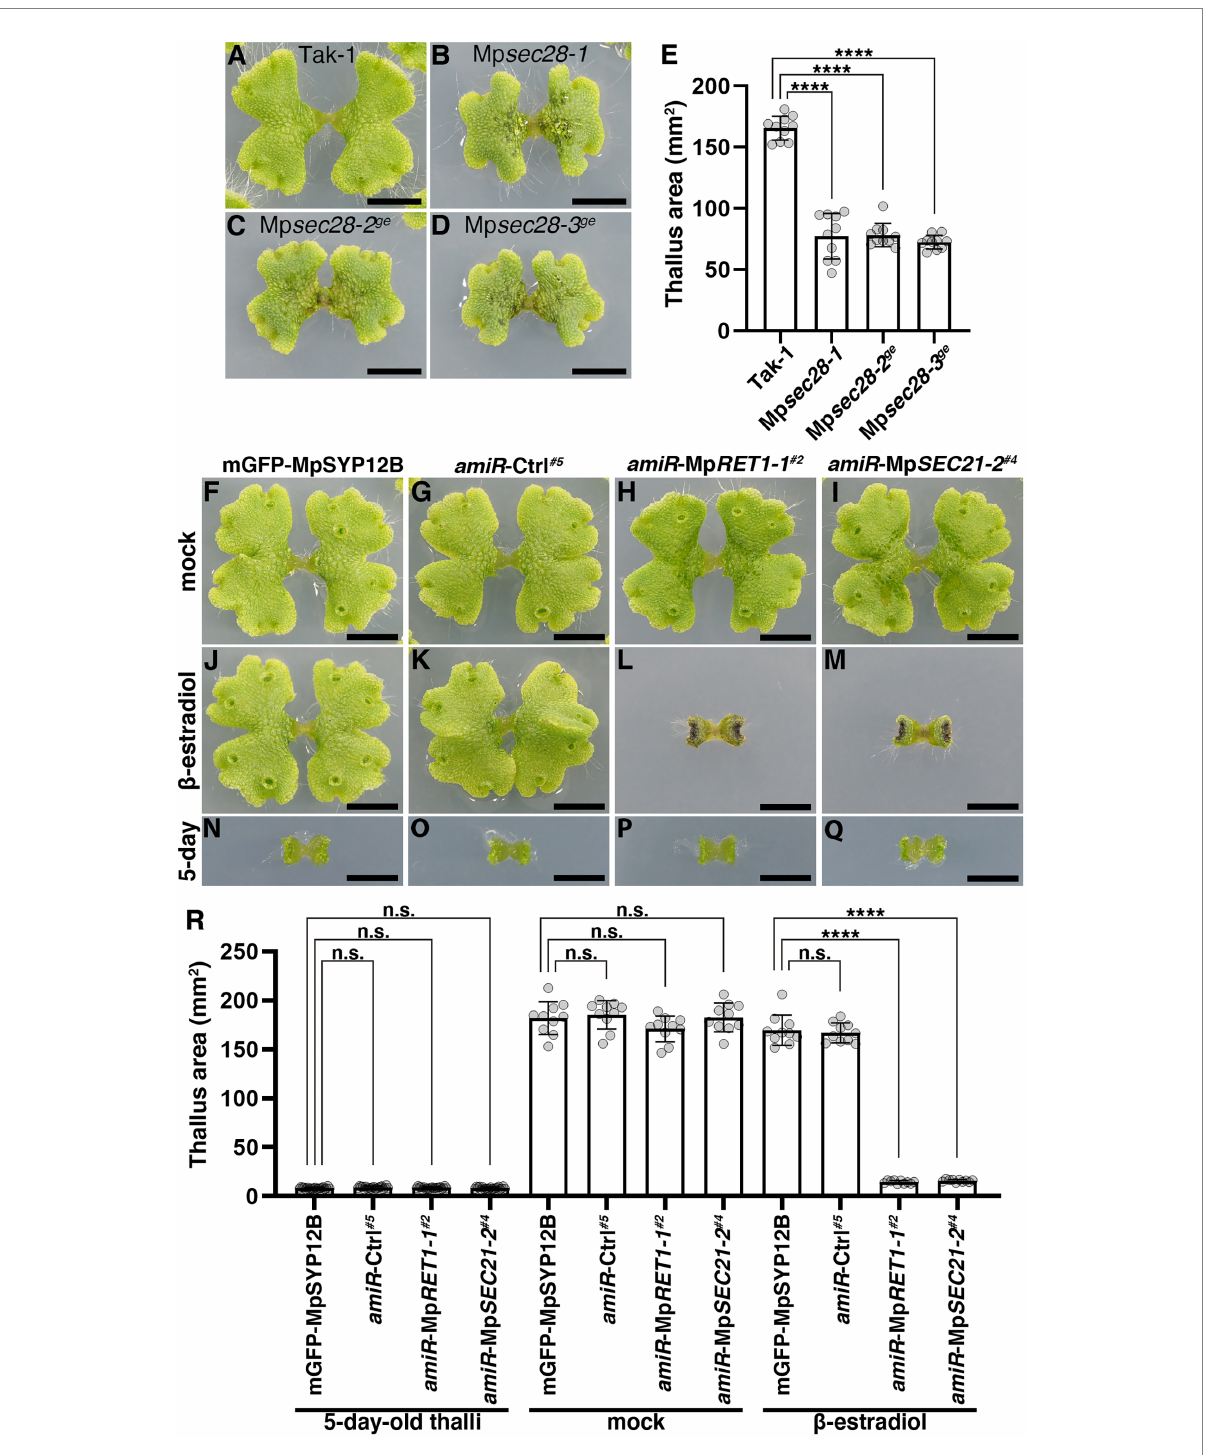
FIGURE 3 Effects of impaired COPI function on thallus growth. (A–D) Twelve-day-old M . polymorpha thalli of Tak-1 (A) , Mp sec28-1 (B) , Mp sec28-2 ge (C) , and Mp sec28-3 ge (D) . Bars = 5 mm. (E) Thallus areas of plants of the indicated genotypes. Data are presented as the means ± s.d. Significant differences between Tak-1 and each mutant were statistically analyzed by a two-tailed Welch’s t -test. **** p < 0.001. Ten thalli were analyzed for each genotype. p = 3.64 × 10 − 09 (Mp sec28-1 ), p = 8.78 × 10 − 14 (Mp sec28-2 ge ), and p = 1.85 × 10 − 13 (Mp sec28-3 ge ). (F–M) M . polymorpha thalli of mGFP- MpSYP12B (F,J,N) , amiR -Ctrl #5 (G,K,O) , amiR -Mp RET1-1 #2 (H,L,P) , and amiR -Mp SEC21-2 #4 (I,M,Q) plants. Five-day-old thalli (N–Q) were transferred and grown on medium plates containing 0.1% (v/v) DMSO (F–I) or 20 μ M β -estradiol (J–M) for 7 days. Bars = 5 mm. (R) The thallus area of 5-day-old plants with indicated genotypes (left) and plants treated with DMSO (mock, middle) or β -estradiol (right) for an additional 7 days. Data are presented as the means ± s.d. Significant differences between mGFP-MpSYP12B and each of the amiR plants were statistically analyzed using a two-tailed Welch’s t -test. n.s., not significant; **** p < 0.001. Twenty (5-day-old thalli) or ten (mock and β -estradiol) thalli were